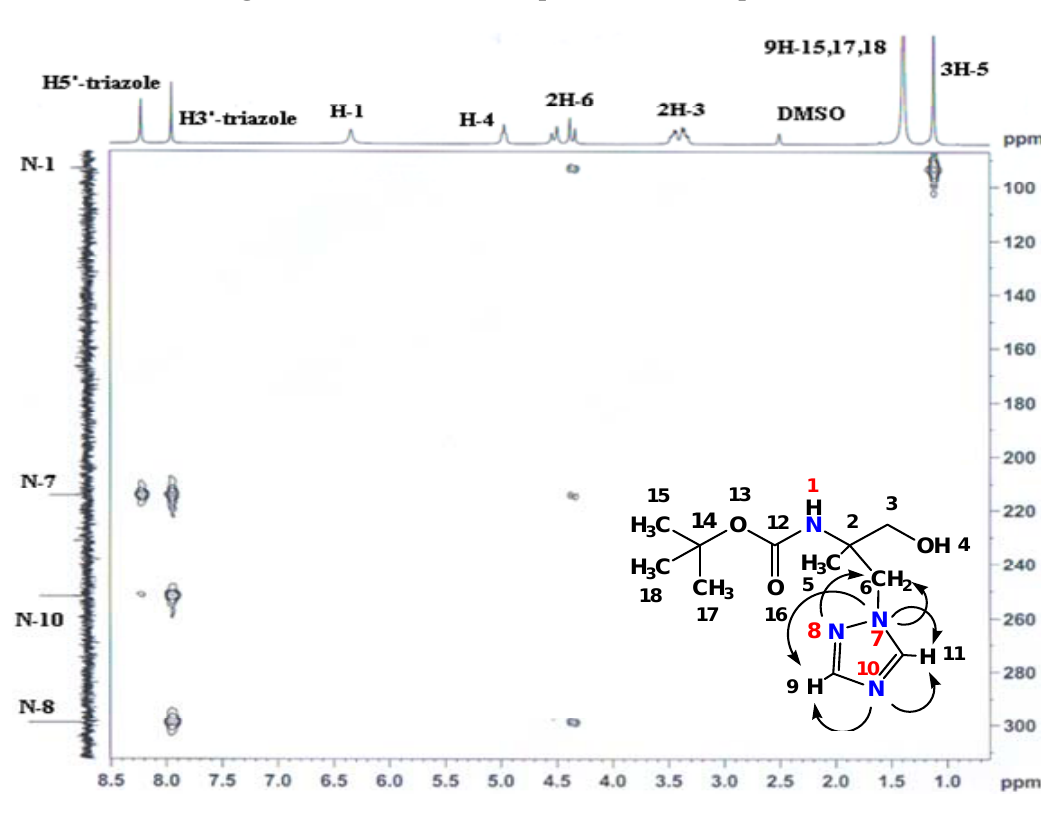
Figure 5. HMBC 1 H– 15 N spectrum for compound 4